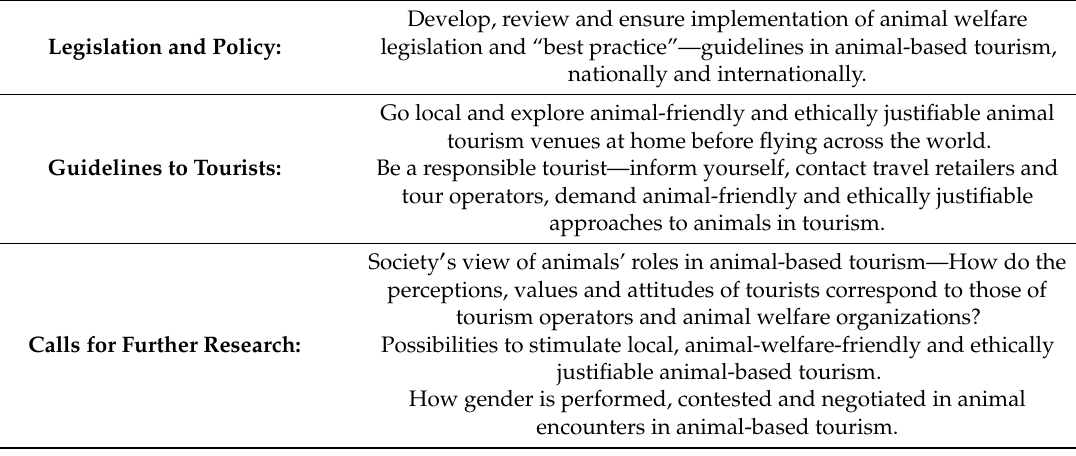
Table 1. Summary of workshop conclusions on legislation and policy, guidelines to tourists and calls for further research on the impact of broader societal structures on animal-based